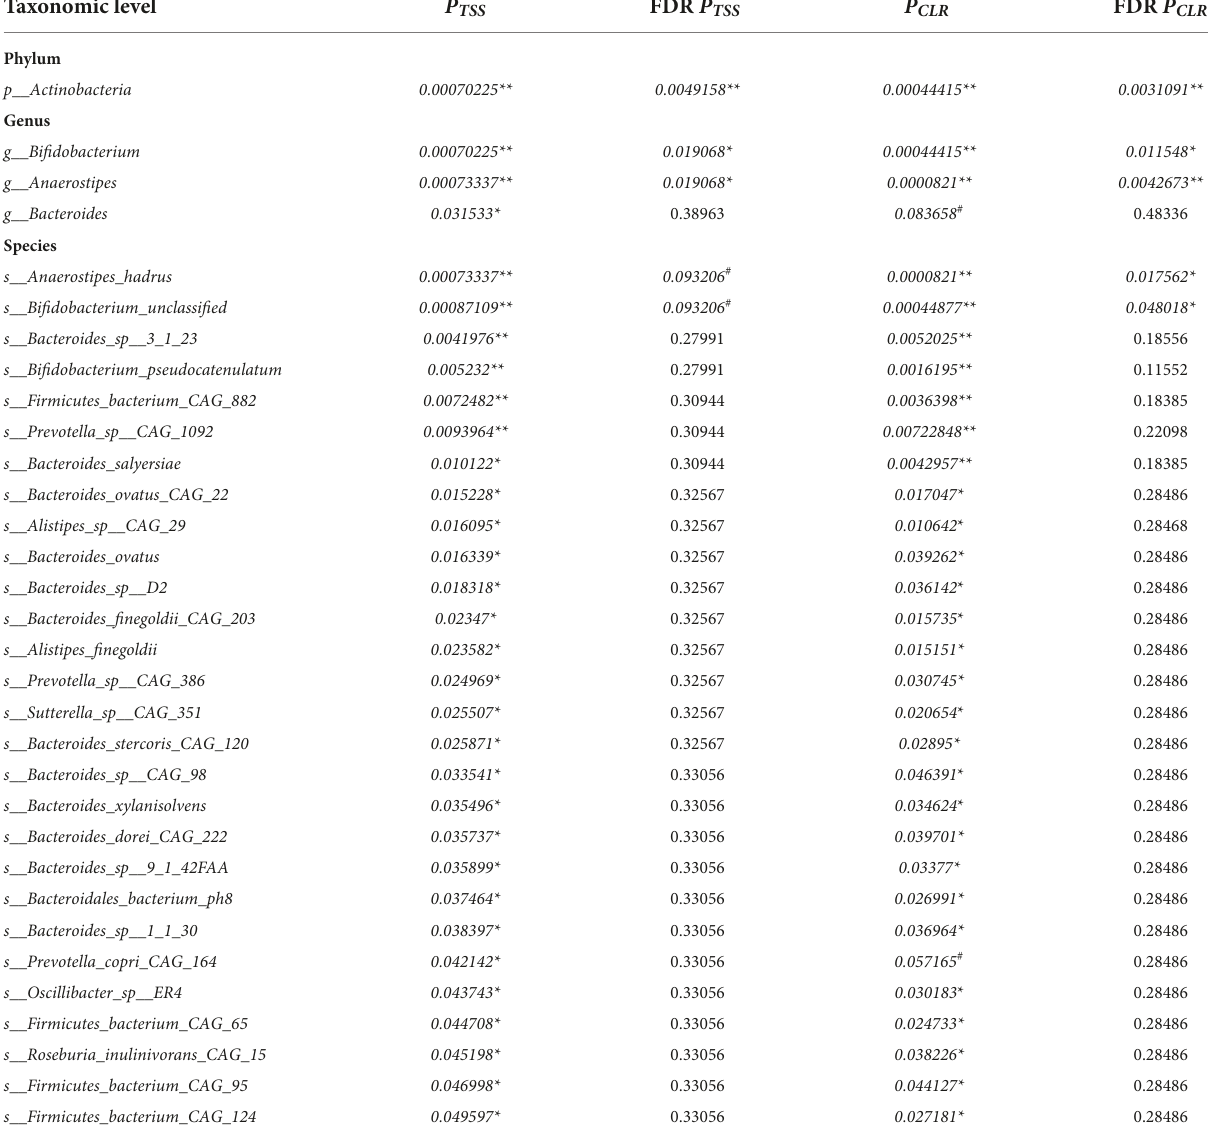
TABLE 4 Gut microbiota associated with cow milk consumption (CMC) via Mann–Whitney test at phylum, genus, and species